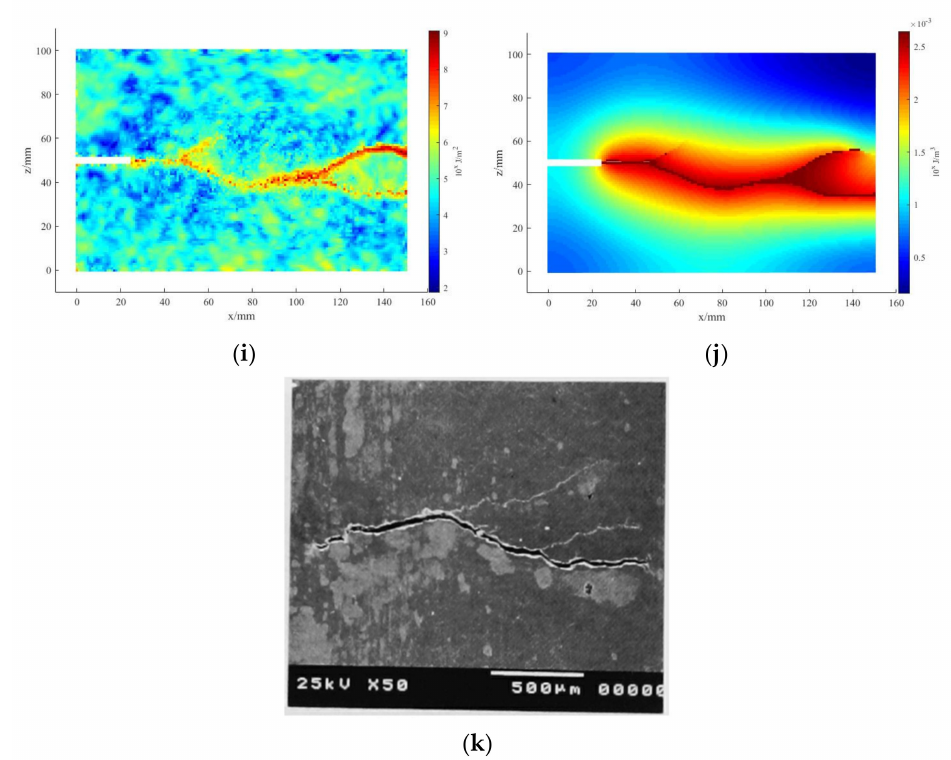
Figure 10. Energy diagram (( a ) t = 400, ( c ) t = 800, ( e ) t = 1200, ( g ) t = 1600, and ( i ) t = 2000), crack propagation path (( b ) t = 400, ( d ) t = 800, ( e ) t = 1200, ( h ) t = 1600, and ( j ) t = 2000), and an SEM image of the sample surface ( k ) when the RH was 75%, with T = 40 t and λ B = 0.5 µ